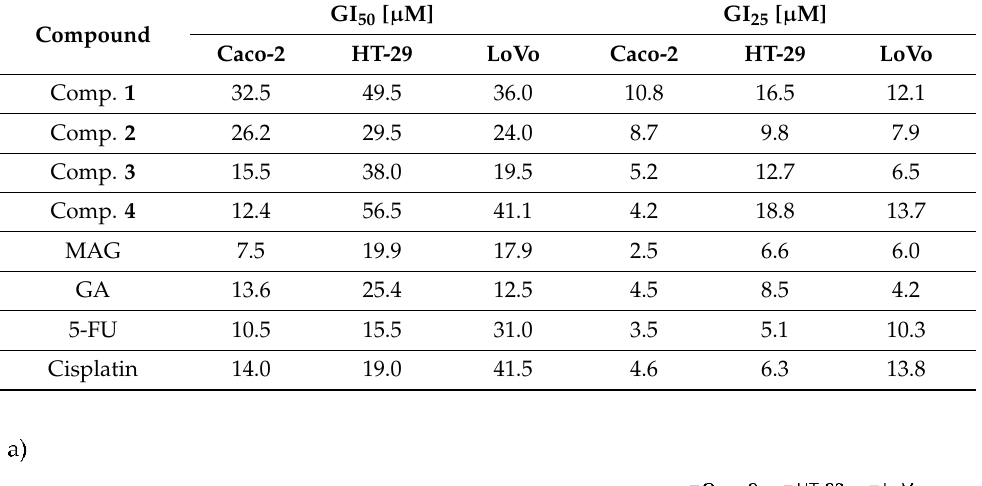
that all xanthones significantly decreased the proliferation of the tumor cell lines com- pared to untreated controls, and their antiproliferative potential was comparable with that of ANX, which served in this study as a control inhibitor of cell proliferation (Figure 1a).